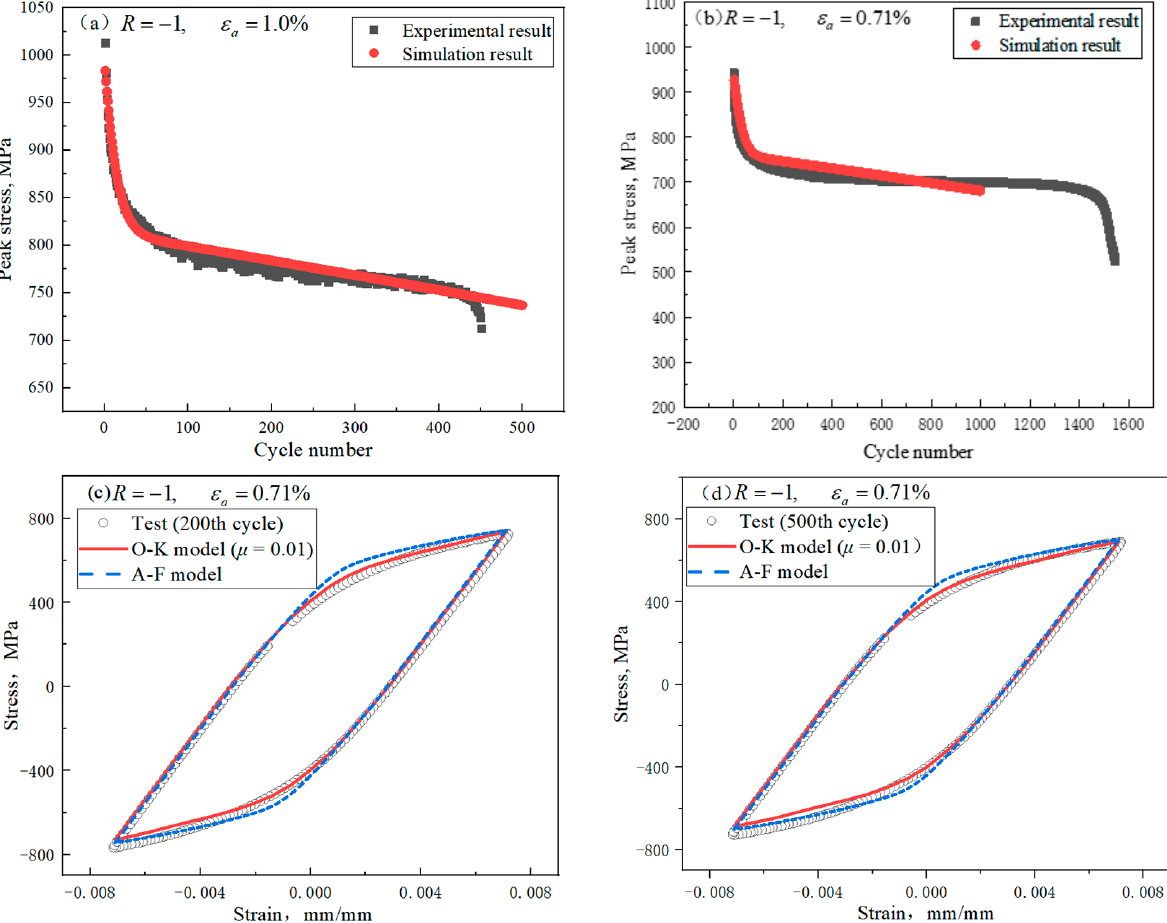
Figure 16. Comparison of symmetric cyclic behavior between tests and simulations: ( a ) ε a = 1.0%; ( b ) ε a = 0.71%; ( c ) the 200th cycle; ( d ) the 500th cycle. Table 3. The parameters of isotropic hardening model.